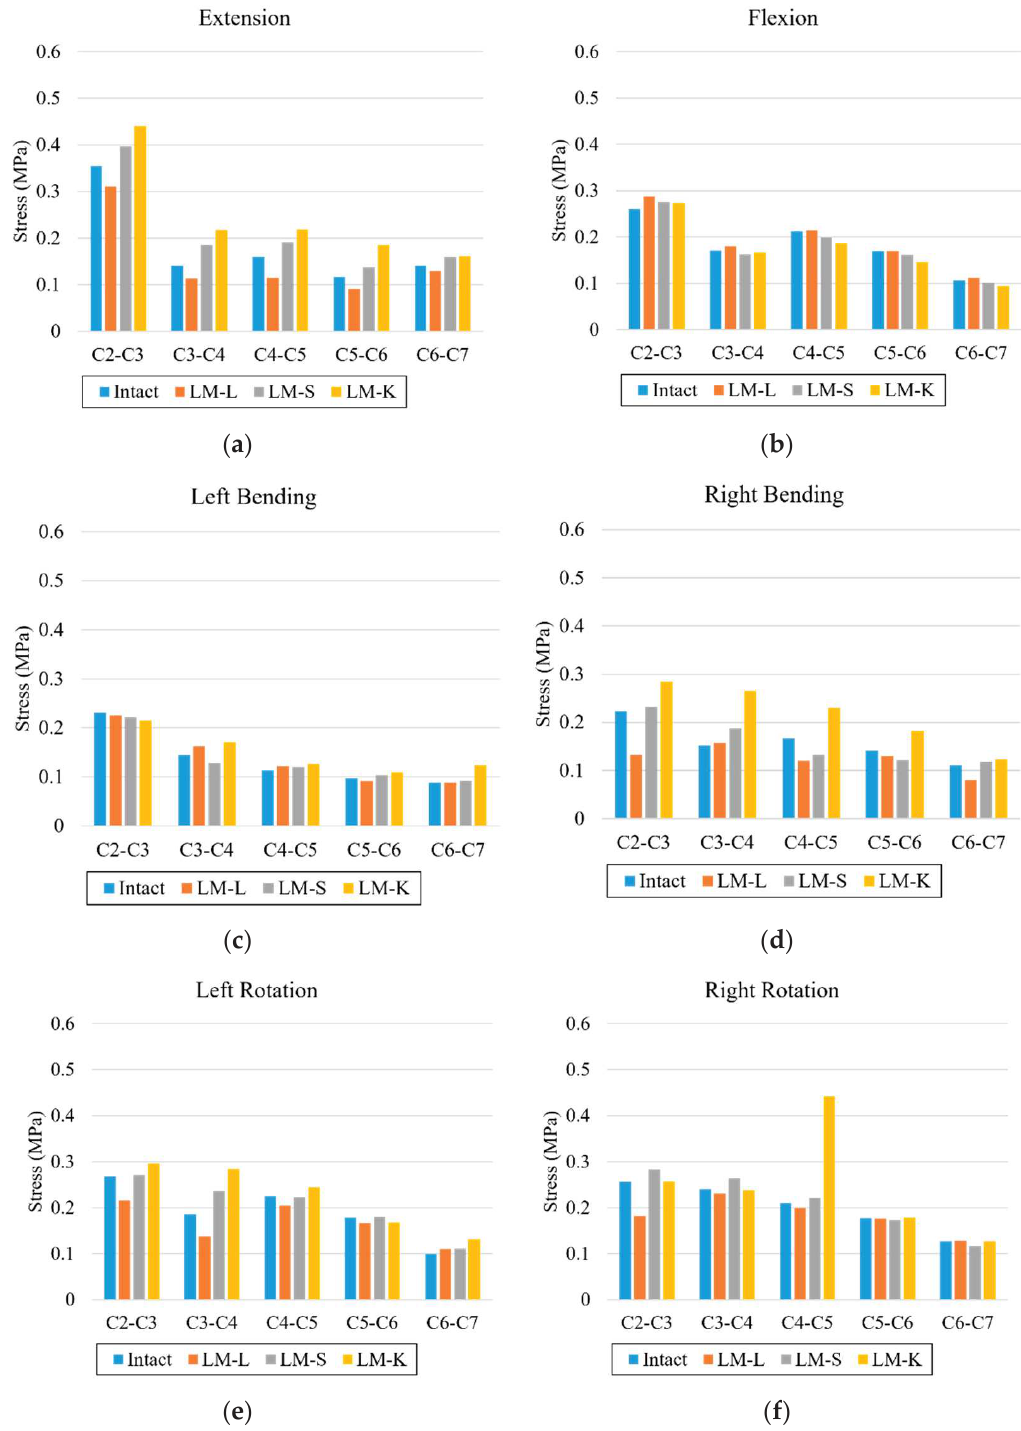
Figure 4. Nucleus stresses: ( a ) extension, ( b ) flexion, ( c ) left bending, ( d ) right bending, ( e ) left rotation, and ( f ) right rotation. The vertical axis is stress (MPa); the horizontal axis is each intervertebral level.